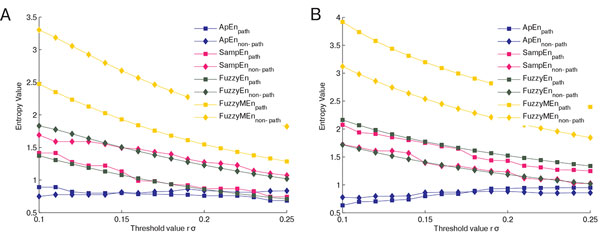
Entropy values for different threshold values (Flip-flop effect). Entropy values for different threshold values r = rL = rF ∈ [0.1σ, 0.25σ] for pathological (square markers) and non-pathological (diamond markers) data sets, parameters: m = 2, n = nL = 3, nF = 2, databases: chf2 vs. np (A) and mit vs. np (B)